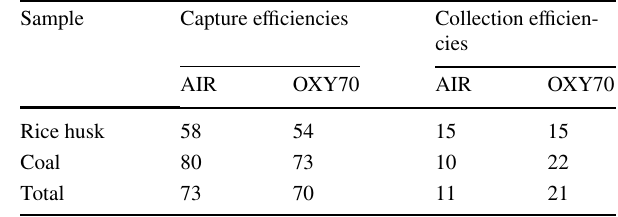
Table 6 % Capture efficiencies ( η capture ) and collection efficiencies ( η collection ) prior to the inclusion of shedding